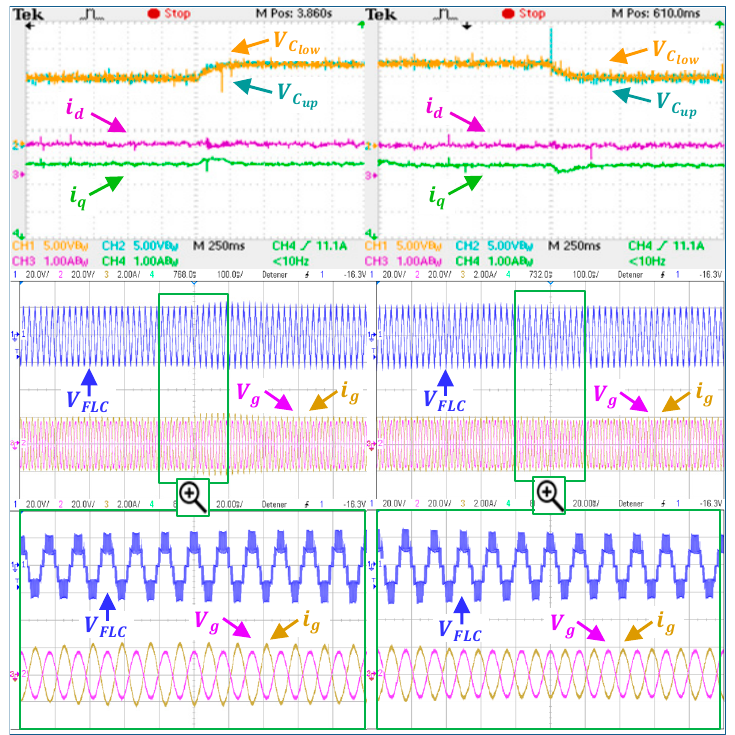
Figure 15. Performance of the voltage balancing strategy and the vector control for the proposed grid-tied SPFLC during a DC bus voltage step-change.